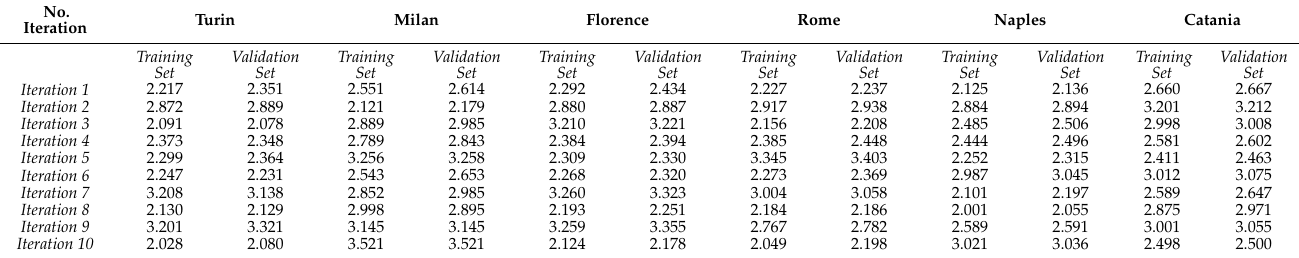
Table 7. Average percentage errors (%) obtained through a ten-fold cross-validation for Phase II. No. Iteration